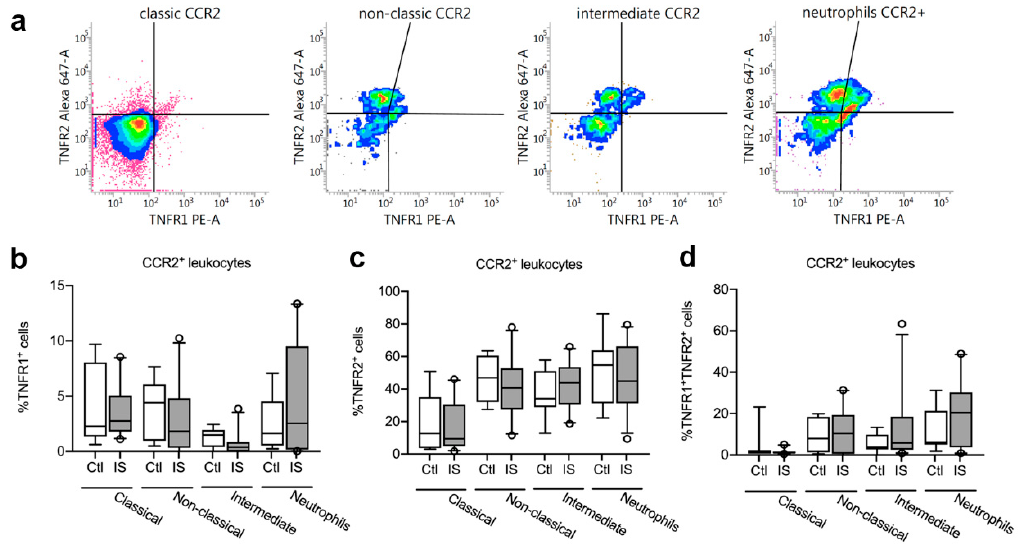
Figure 4. Characterization of TNFR1 and TNFR2 expression on CCR2 + monocytes and neutrophils. ( a ) Flow cytometry analysis of TNFR1 and TNFR2 expression on CCR2 + classical, non-classical, and intermediate monocytes and on neutrophils in ischemic stroke (IS) patients ( n = 23) and healthy controls (Ctl, n = 8). ( b ) Quantification of the percentage of TNFR1 + CCR2 + monocyte subsets and neutrophils in IS and healthy Ctl. ( c ) Quantification of the percentage of TNFR2 + CCR2 + monocyte subsets and neutrophils in IS and healthy Ctl. ( d ) Quantification of the percentage of TNFR1 + TNFR2 + CCR2 + monocyte subsets and neutrophils in IS and healthy Ctl. Line: median. Box: 25–75% interquartile range. Whiskers: 5–95% percentile. TNFR, tumor necrosis factor receptor.